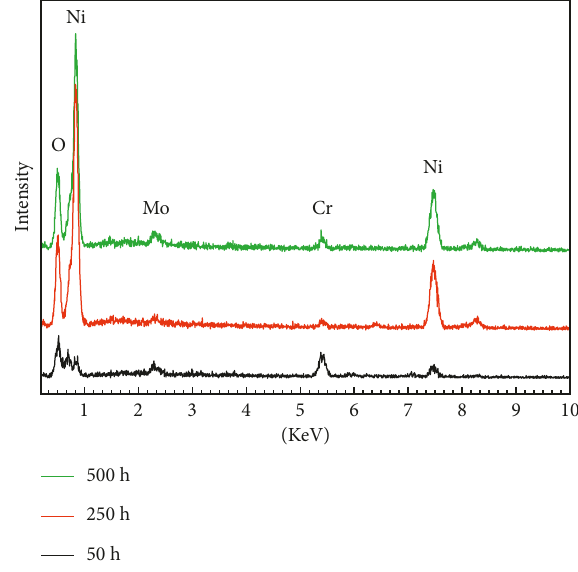
Figure 4: EDS spectrum of oxide scales grown on C-276 in SCW for different